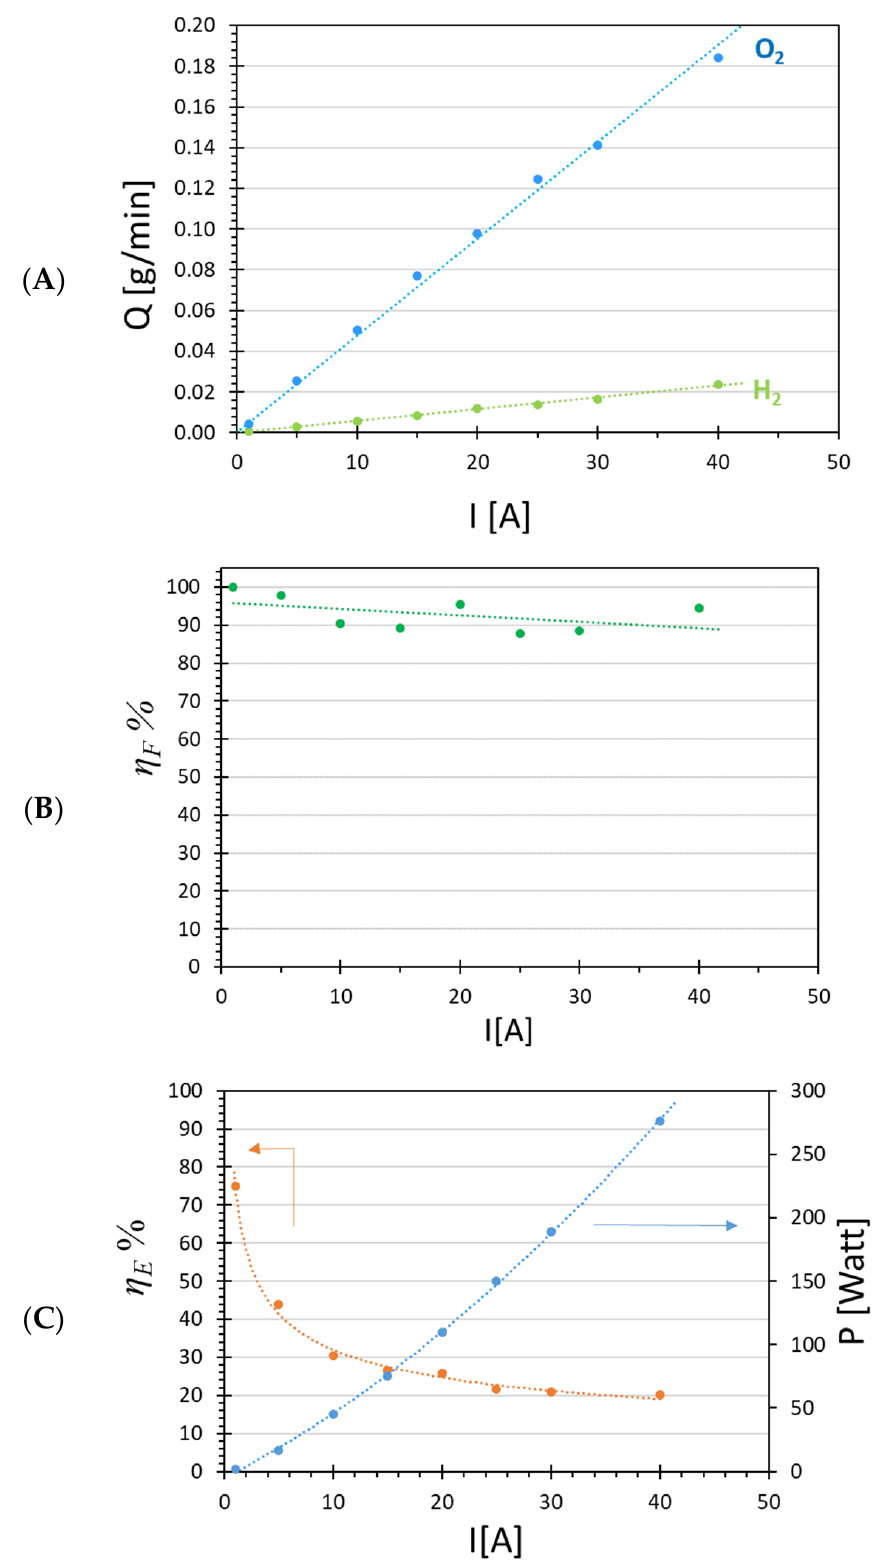
Figure 6. Flow rate of H 2 and O 2 produced ( A ), Faradaic efficiency ( B ), energy efficiency and electrical power ( C ) as function of electrical current applied for the Ir-Pt-Nafion™ 117 CCM. Slight fluctuations in the Faradaic efficiency were probably related to the change in temperature that occured during increased electrical current run (Figure 7C).